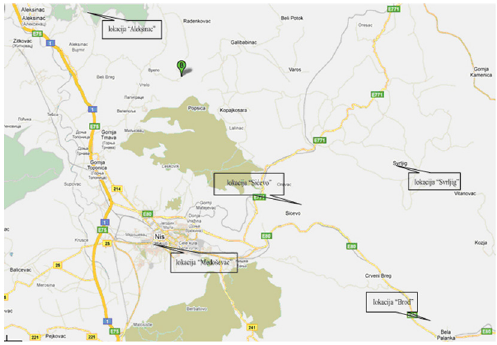
Figure 1: Layout of locations where samples were taken: Sićevo (1), Brod (2), Aleksinac (3), Svrljig (4) and Medoševac